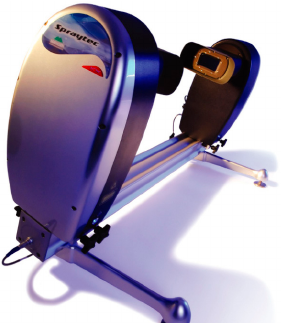
Figure 2. Schematic of the laser particle size analyzer.